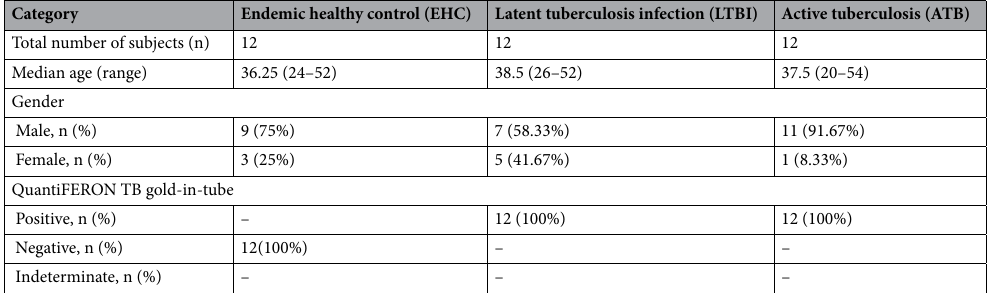
Table 1. Characteristics of subjects for peptide microarray